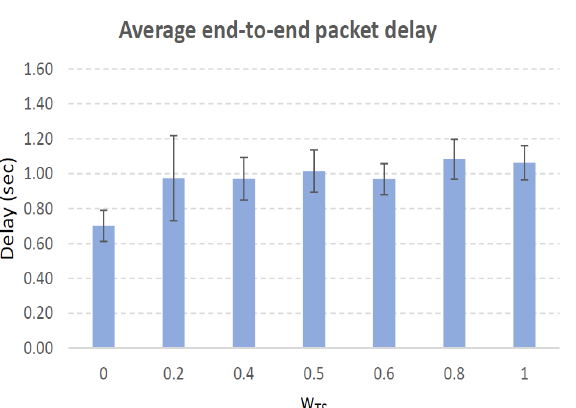
Figure 15. Average end-to-end packet delay. Scenario with high social media interaction (TS normal distribution with µ = 3 and σ = 1). Nodes’ density = 200 nodes/km 2